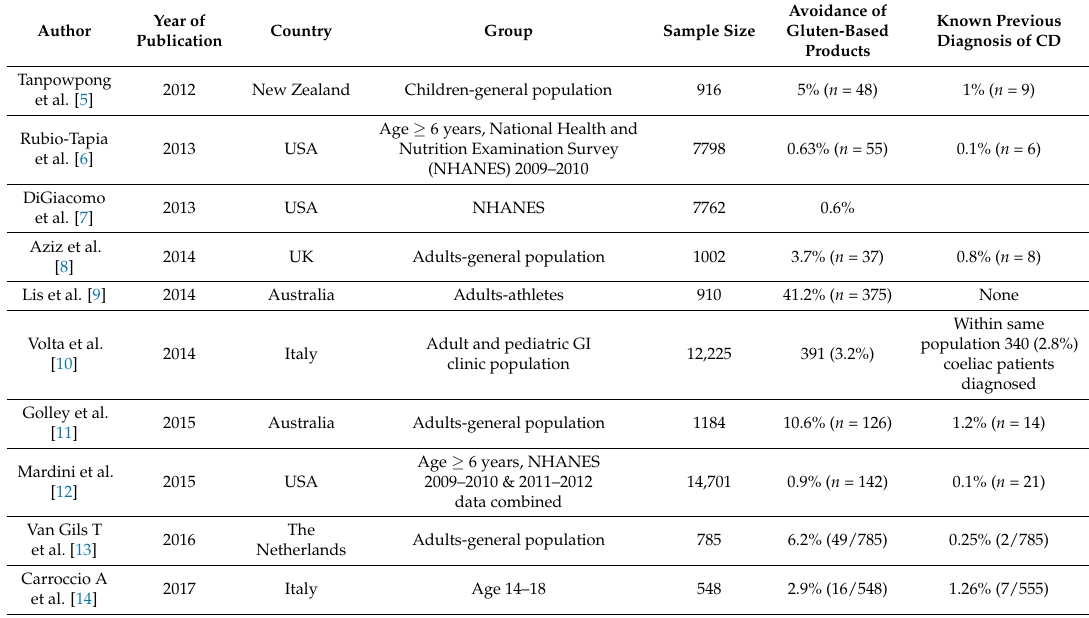
Table 1. Prevalence studies of people avoiding gluten-based